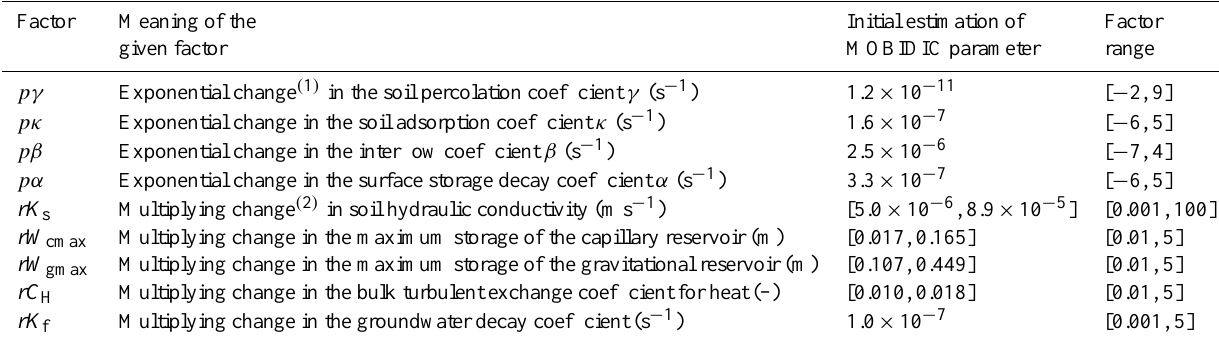
Table 1. Initial selected factors, initial estimation of the corresponding MOBIDIC parameter, and factor ranges. Factor Meaning of the Initial estimation of Factor given factor MOBIDIC parameter range pγ Exponential change ( 1 ) in the soil percolation coefficient γ (s − 1 ) 1.2 × 10 − 11 pκ Exponential change in the soil adsorption coefficient κ (s − 1 ) 1.6 × 10 − 7 pβ Exponential change in the interflow coefficient β (s − 1 ) pα Exponential change in the surface storage decay coefficient α (s − 1 ) rK s Multiplying change ( 2 ) in soil hydraulic conductivity (ms − 1 ) rW cmax Multiplying change in the maximum storage of the capillary reservoir (m) rW gmax Multiplying change in the maximum storage of the gravitational reservoir (m) rC H Multiplying change in the bulk turbulent exchange coefficient for heat (–) rK f Multiplying change in the groundwater decay coefficient (s − 1